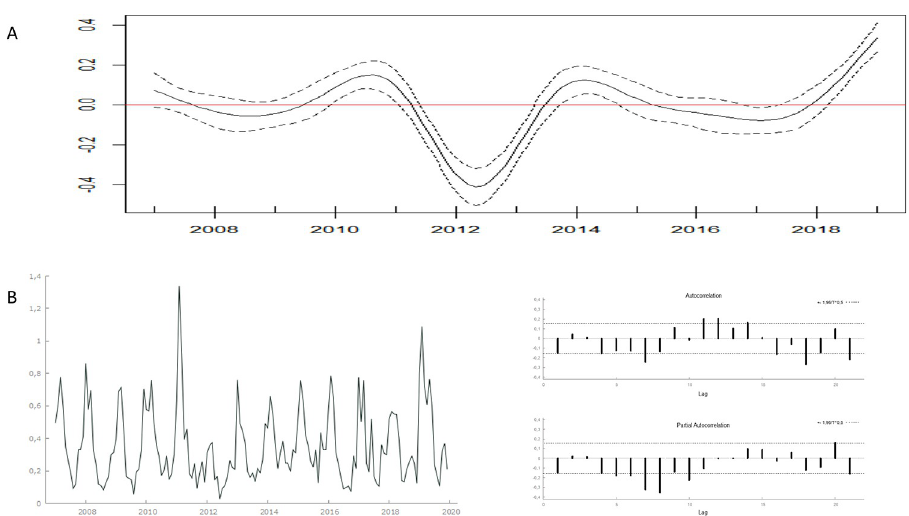
Fig 4. Temporal distribution of leptospirosis incidence rate (per 100,000 inhabitants) between 2007 and 2019 in Rio Grande do Sul, Brazil, (A) estimated by Generalized Additive Model (GAM) with Poisson distribution and a spline function in the continuous time variable, with 95% confidence interval (p < 0.01, R 2 = 75.9%) and (B) time series descriptive evaluation in the period, with the autocorrelation function (ACF) and the partial autocorrelation function (PACF)